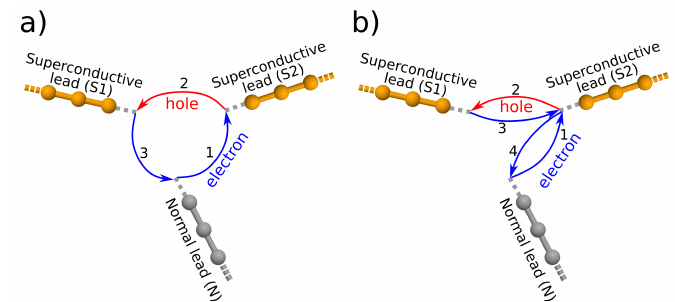
Figure 9. ( a ) An example for interfering paths having an amplitude of opposite sign for the electron- and hole-like particles. These kinds of paths have an odd number of propagation through the molecular core. ( b ) A representative of trajectories consisting of even number of propagations through the molecular core. The amplitude of these kinds of trajectories have the same sign for the electron- and hole-like